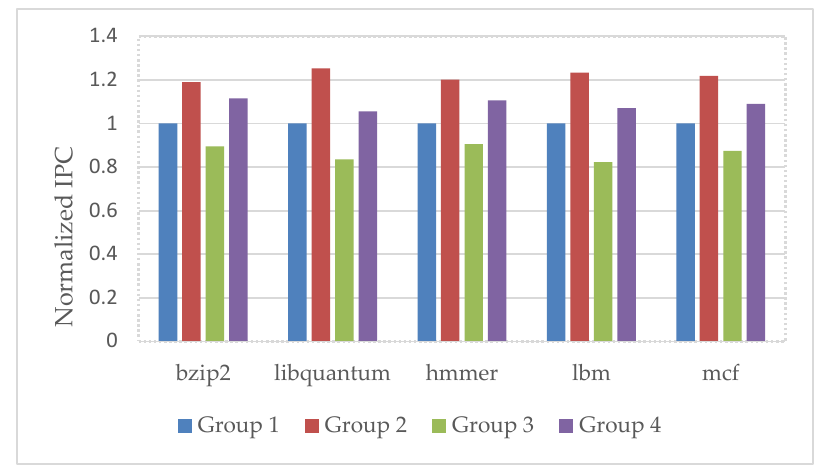
Figure 12. Comparison of IPC normalized to group 1.